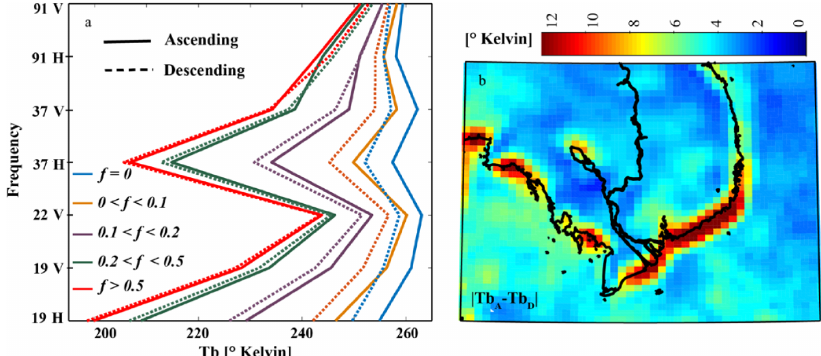
Figure 4. (a) The systematic difference between passive microwave observations from the ascending (solid lines) and descending orbits (broken lines) as a function of five different sub-pixel intervals of inundation fractions. (b) July to December daily average of absolute differences between the ascending (Tb A ) and descending (Tb D ) brightness temperatures at vertically polarized 19GHz channel. The values of | Tb A − Tb D | mainly capture the coastal regions with significant variability in their surface emissivity values due frequent diurnal tidal effects.